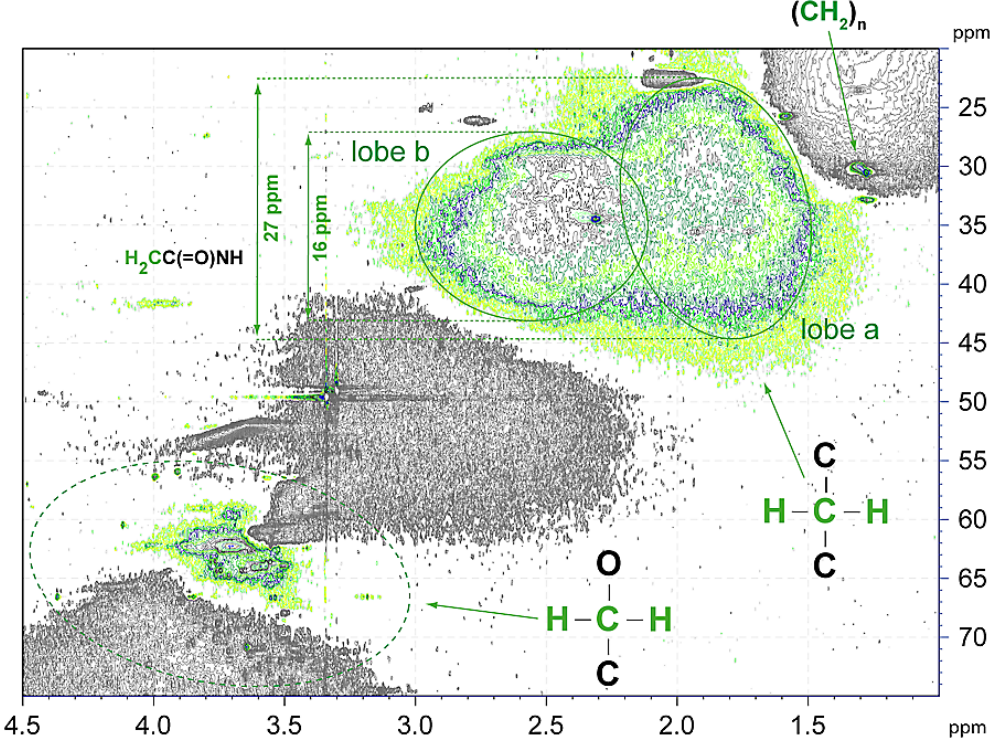
Fig. 8b. DEPT-HSQC NMR spectra of surface marine SPE-DOM at 5m. Section of H 2 C -Z (Z=C, O, (N, S)) cross peaks. Polymethylene (CH 2 ) n experiences the least number of aliphatic neighbours and occupies a low intensity cross peak ( < 1% of methylene cross-peak integral) in a confined area at high field. Carbon bound methylene decompose into two major lobes; the right lobe a ( δ H : 1.5–2.2ppm) occupied a sizable carbon chemical shift range ( 1δ C ) of 27ppm, whereas the lower field lobe b ( δ H : 2.2–3.0ppm) occupied a smaller carbon chemical shift range ( 1δ C ) of 16ppm. These two units differ in the position of COX derivatives with respect to the observed H 2 C -Z unit, which is directly adjacent to lobe b (i.e. C-CH 2 -COX) and two or more bonds away for lobe a. COX at positions one ( α -position) and two ( β -position) bonds away from methylene carbon (i.e. C-CH 2 -C x -COX; x ≥ 1) will displace aliphatics which otherwise would impose sizable carbon downfield shifts in the range of 1δ C ∼ 9ppm; in addition, proximate COX derivatives will cause downfield proton chemical shift because of chemical shift anisotropy of the carbonyl group (lobe b). COX at positions three ( γ -position) bonds away from methylene carbon will cause lower chemical shift anisotropy in proton NMR and obviate a shielding increment for γ -aliphatic substitution ( 1δ C : − 0.8ppm), leaving δ C and δ H nearly unaltered from standard aliphatic (branched) substitution (lobe a). Several recognizable intensity maxima of aliphatic methylene C- CH 2 -C likely reflected superposition of remotely substituted common geometries of aliphatic branching. Oxomethylene ( H 2 C - O) chemical environments in marine SPE-DOM commonly represent carbohydrate side chains of considerable diversity alongside with other minor oxomethylene cross